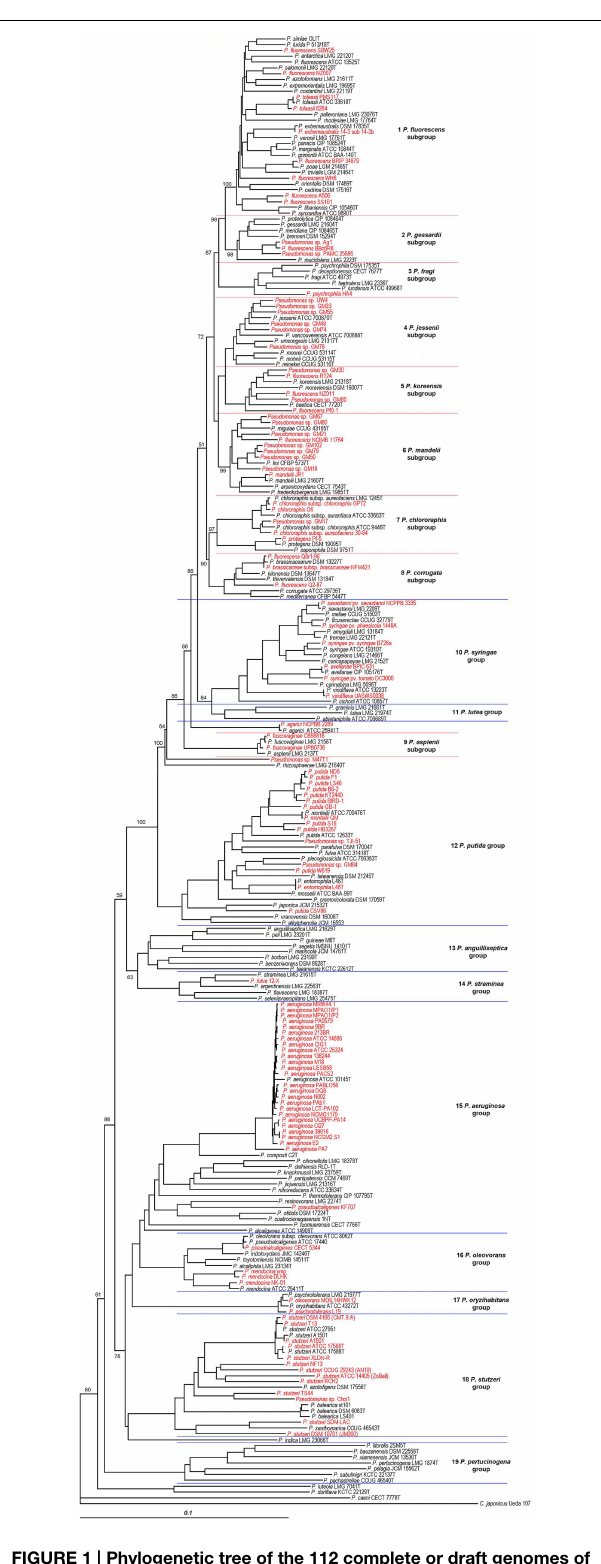
FIGURE 1 | Phylogenetic tree of the 112 complete or draft genomes of strains related to the genus Pseudomonas and the 141 well